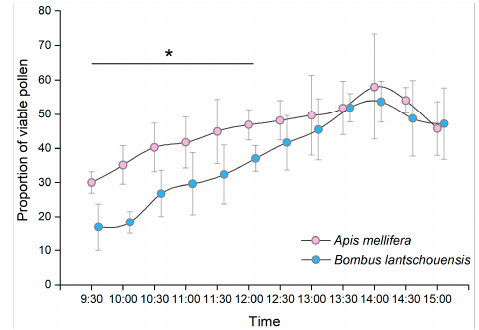
Figure 7. Temporal differences in the proportion of viable pollen carried by Apis mellifera and Bombus lantschouensis in the peach solar greenhouse. Data are presented as the mean ± S.D. The difference in the viability of pollen carried by Apis mellifera and Bombus lantschouensis was tested by the Mann–Whitney U method. The “*” indicates significant differences ( p < 0.05) between A. mellifera and B. lantschouensis at each time point.